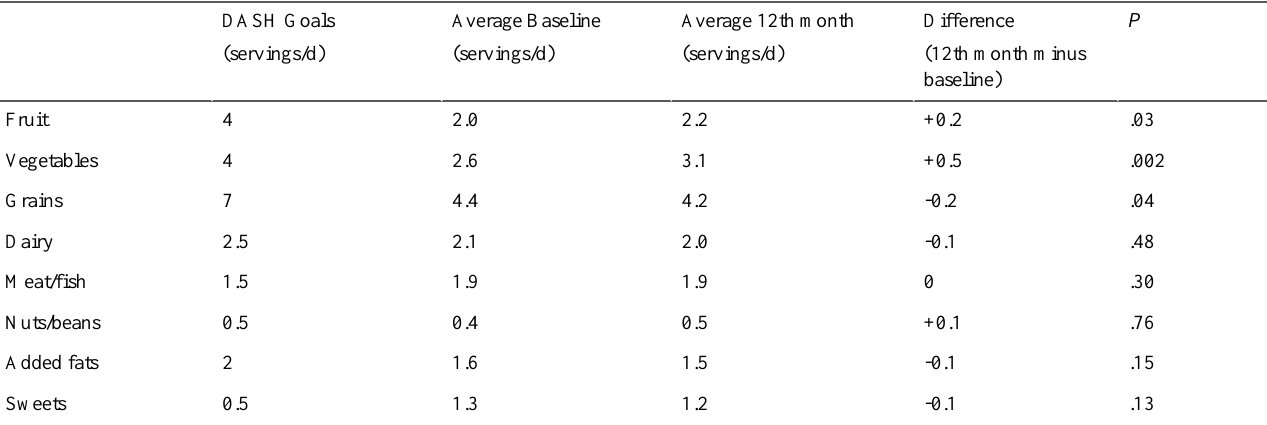
Table 4. Changes in consumption of the eight main DASH food groups from baseline to the 12th month of DASH for Health (n = 181)